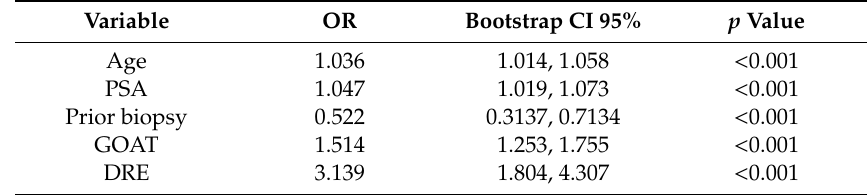
Table 2. Multivariate analysis of the association of plasma GOAT levels with the diagnosis of prostate cancer in the full cohort of patients adjusting with common clinical variables. Variable OR Bootstrap CI 95% p Value Age 1.036 1.014, 1.058 < 0.001 PSA 1.047 1.019, 1.073 < 0.001 Prior biopsy 0.522 0.3137, 0.7134 < 0.001 GOAT 1.514 1.253, 1.755 < 0.001 DRE 3.139 1.804, 4.307 <